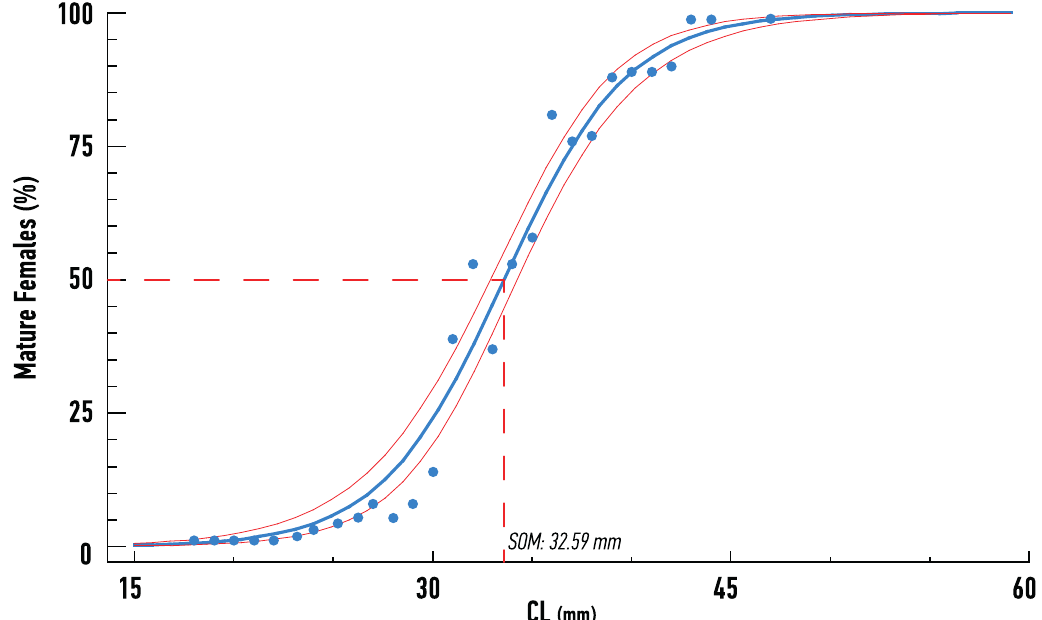
Figure 7. Maturity ogive and confidence limits estimated by Probit analysis, indicating average mean size at onset of maturity (SOM) of Nephrops females from Pagasitikos Gulf, Eastern Mediterranean, Greece. Table 2. Values of the Von Bertalanffy Growth Function of Nephrops, estimated by a non-linear regression and Morality values, estimated by several models incorporated in the FiSAT II software, for each year of sampling and for each sex. (CL inf = asymptotic carapace length, K = growth coefficient, t 0 = hypothetical age at zero length, Z = total mortality, M = natural mortality, F = fishing mortality, E = exploitation rate). Year CL inf (mm)